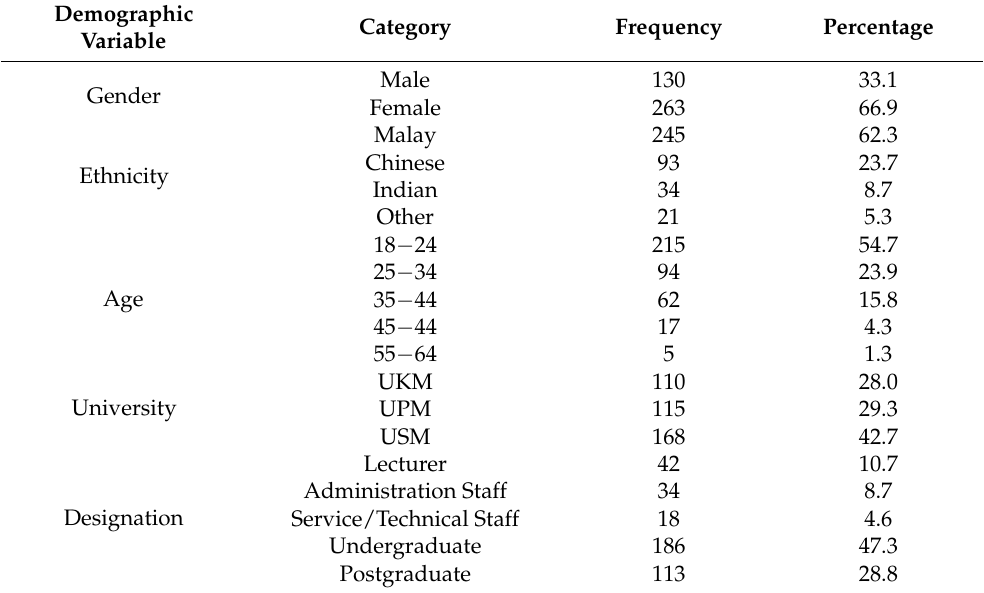
Table 8. Profiles of